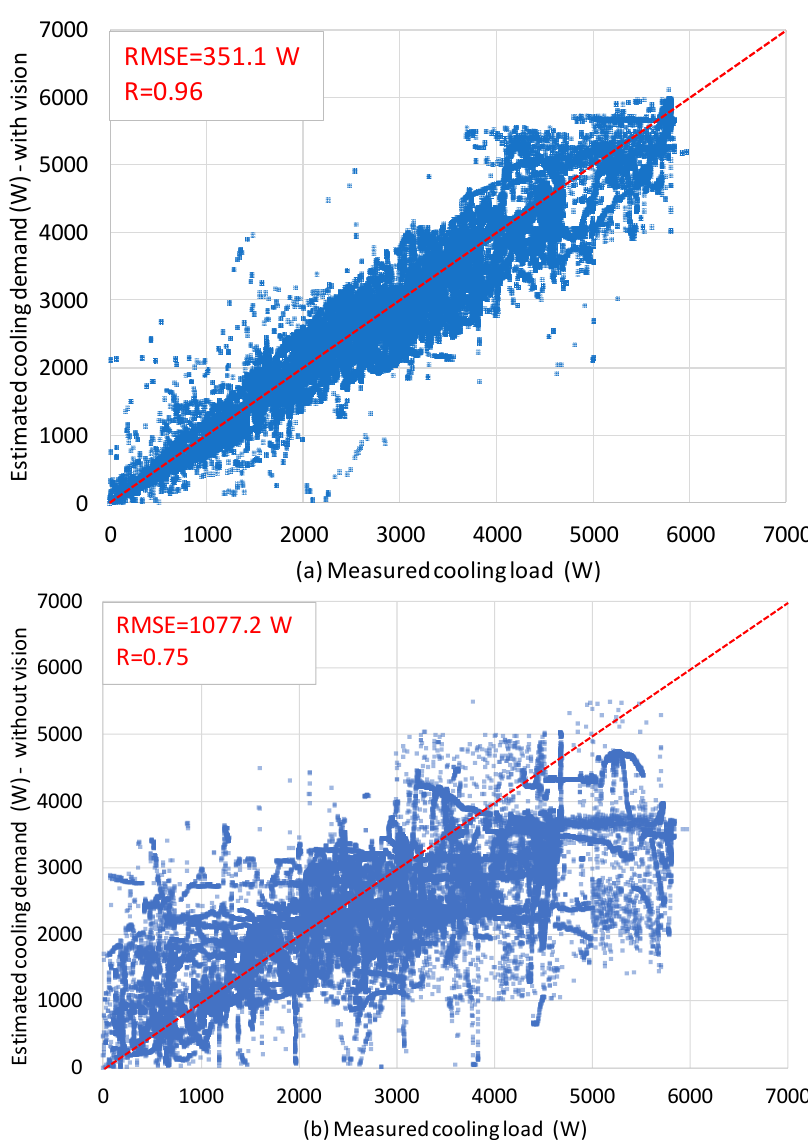
Figure 16. Measured and estimated cooling demand ( a ) with vision-based occupancy information; ( b ) without vision-based occupancy information (darker area represents more data points).